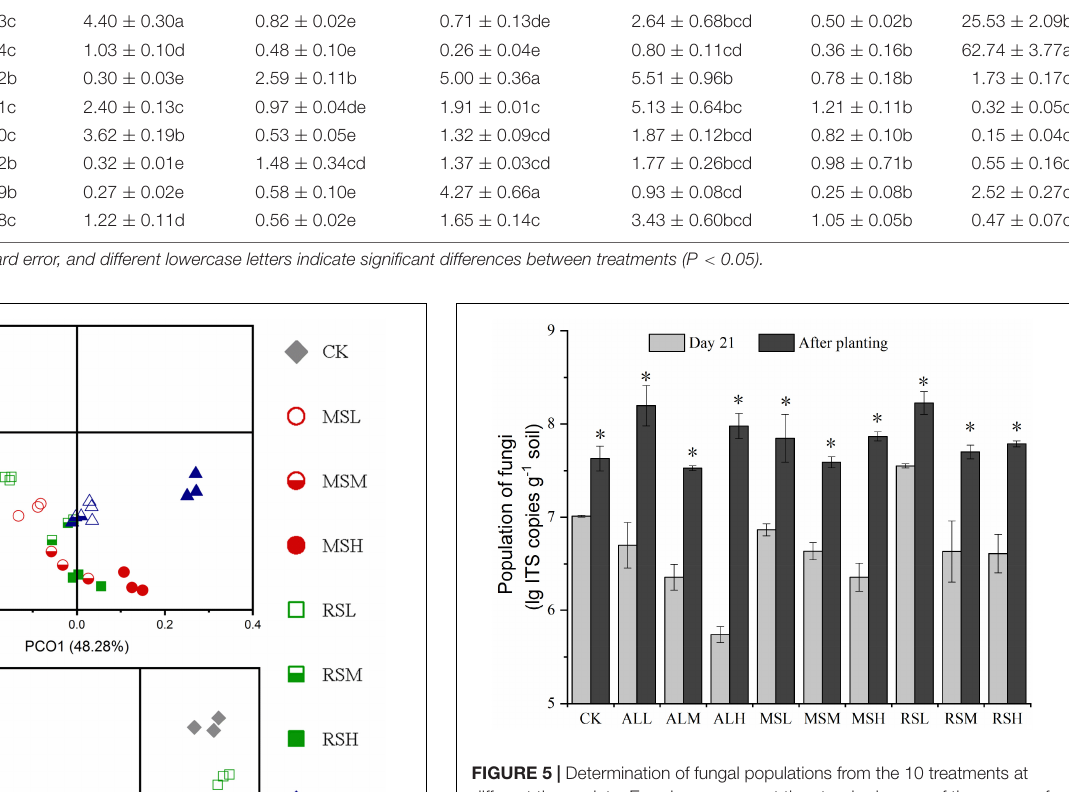
FIGURE 5 | Determination of fungal populations from the 10 treatments at different time points. Error bars represent the standard errors of the means of three replicates. ∗ P <